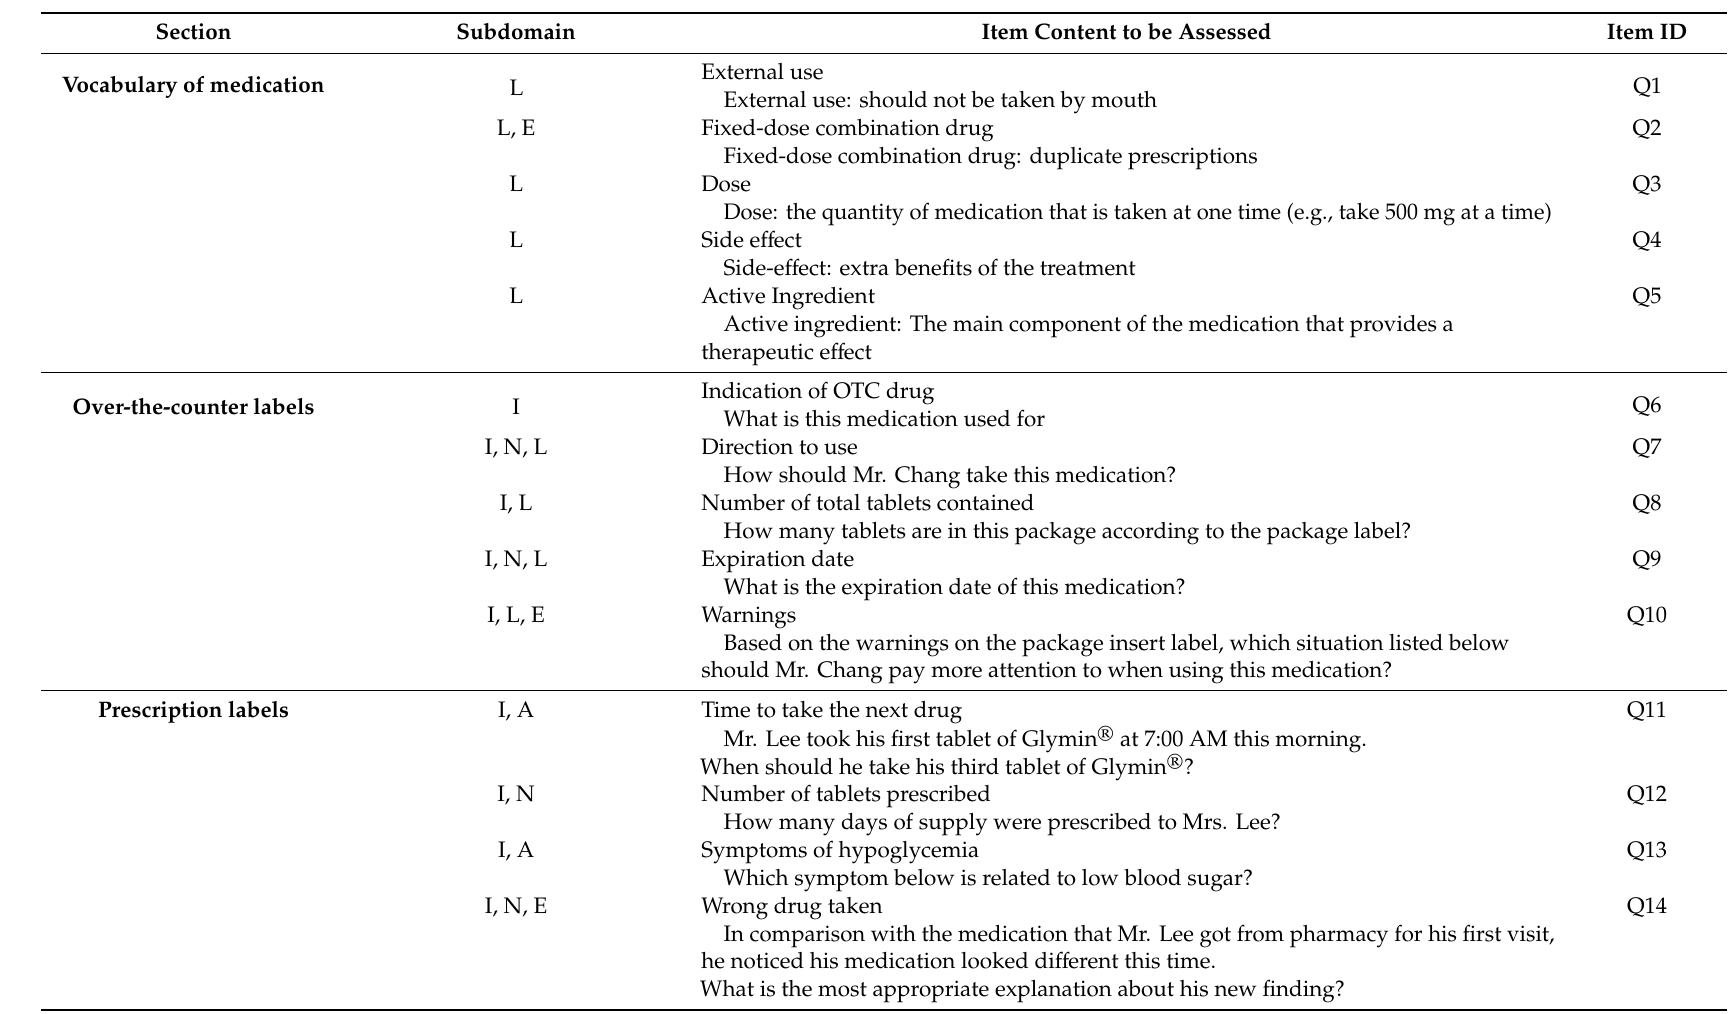
Table 1. Item content and original item stem included in the